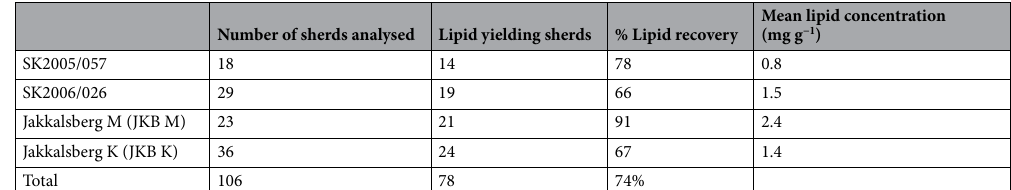
Number of sherds analysed Lipid yielding sherds % Lipid recovery